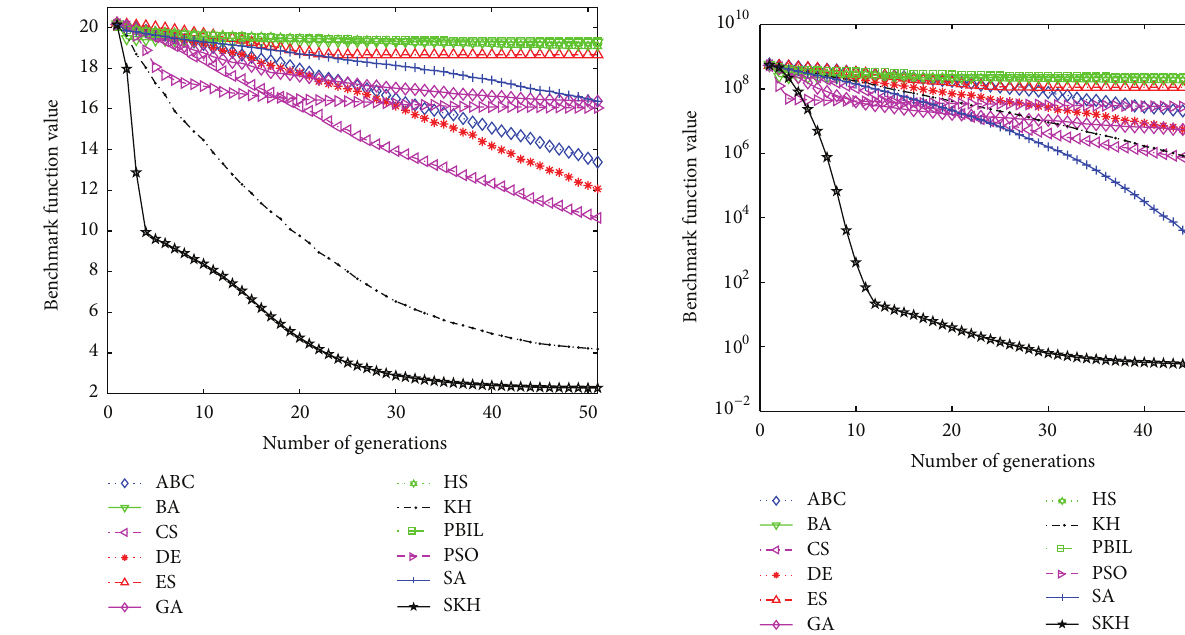
Figure 3: Comparison of the performance of the different methods for the F05 Penalty.